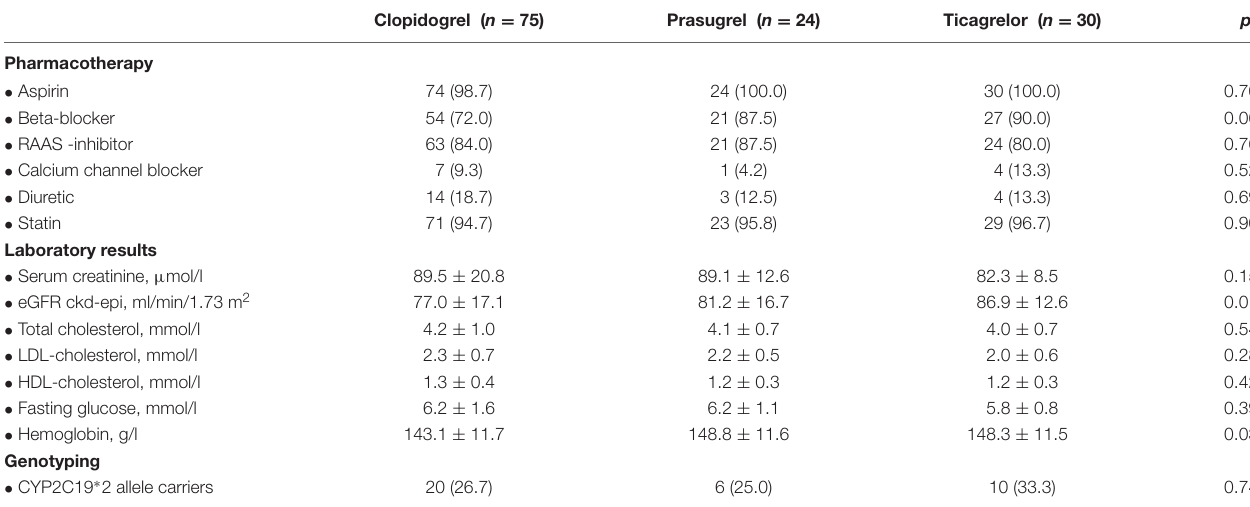
TABLE 2 | Pharmacotherapy, biological results and genotyping of the study patients according to the anti-P2Y12 drug at